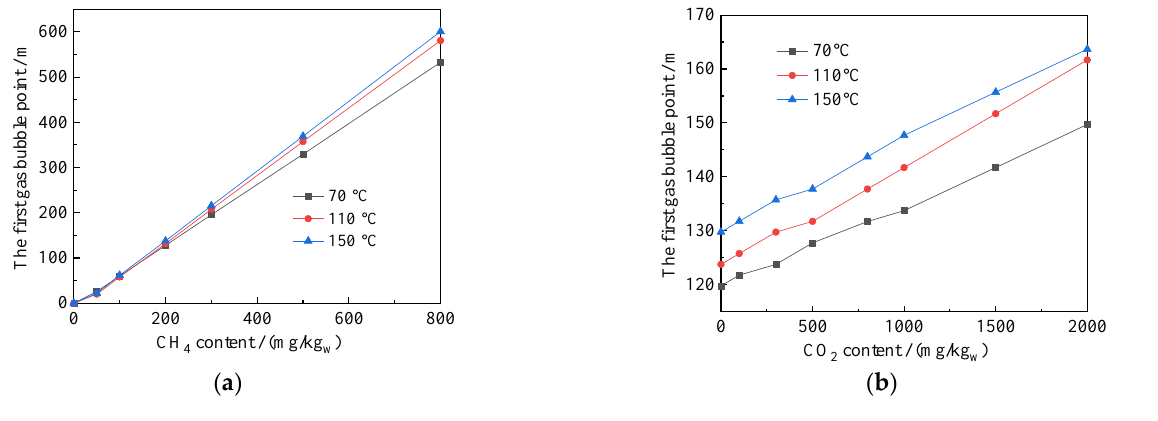
Figure 7. The effect of CH 4 ( a ) and CO 2 ( b ) contents on the first gas bubble point. The position of scale is right at the wellhead. The logging truck results were recorded in an Excel spreadsheet that recorded tem- perature and pressure data points every 10 m. Part of the data is shown in Table 5. The static water surface is at a depth of 72 m. The temperature and pressure of the geothermal water in the bottom of the well (depth of 3570 m) are 142.937 ◦ C and 32.89 MPa,